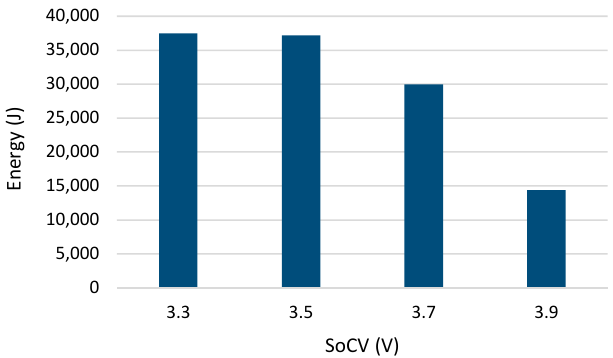
Figure 10. Energy consumption of battery charging for different values of SoCV.